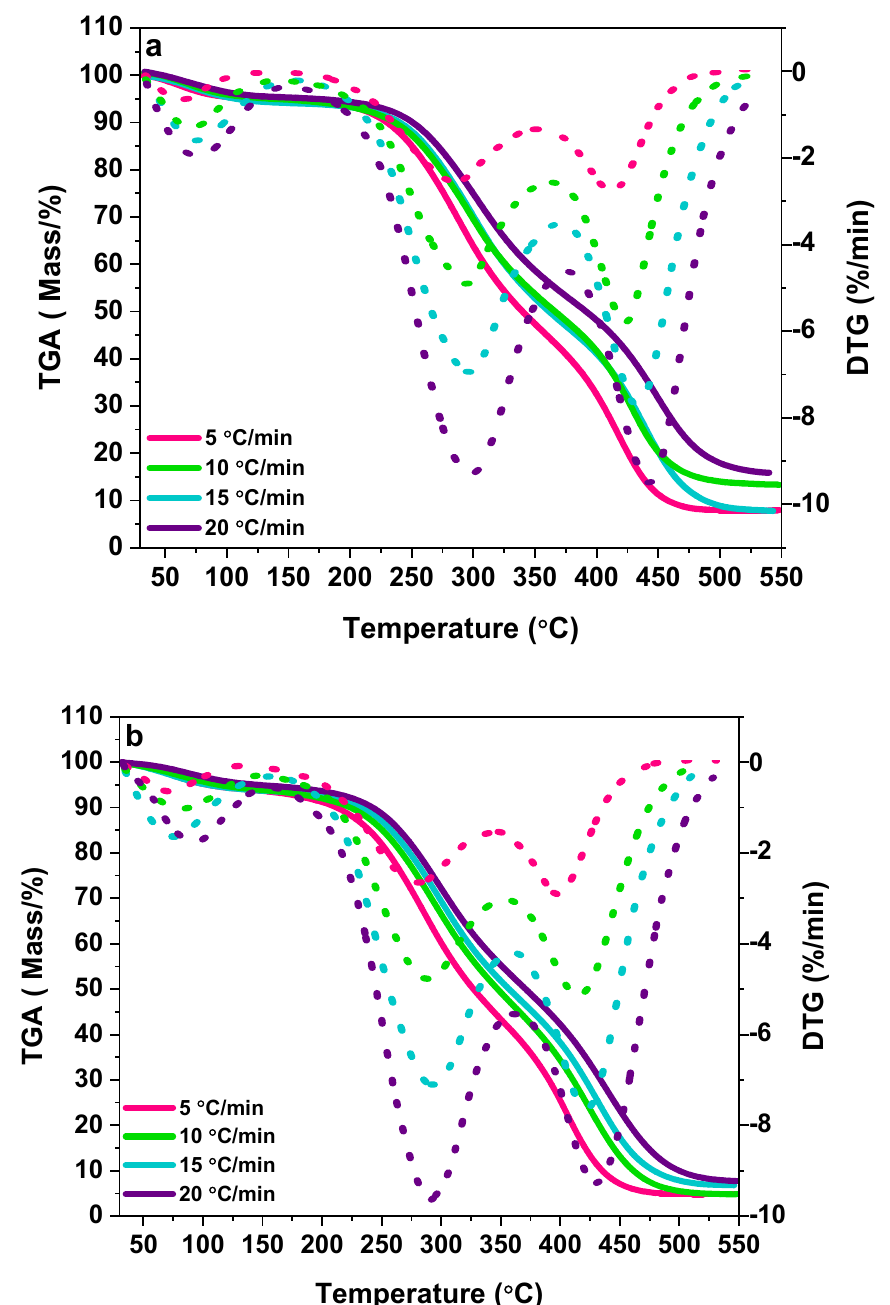
Figure 1 . Thermal gravimetric and differential thermal gravimetric curves of the non-catalytic ( a ) and catalytic ( b ) processes of peat oxidation.